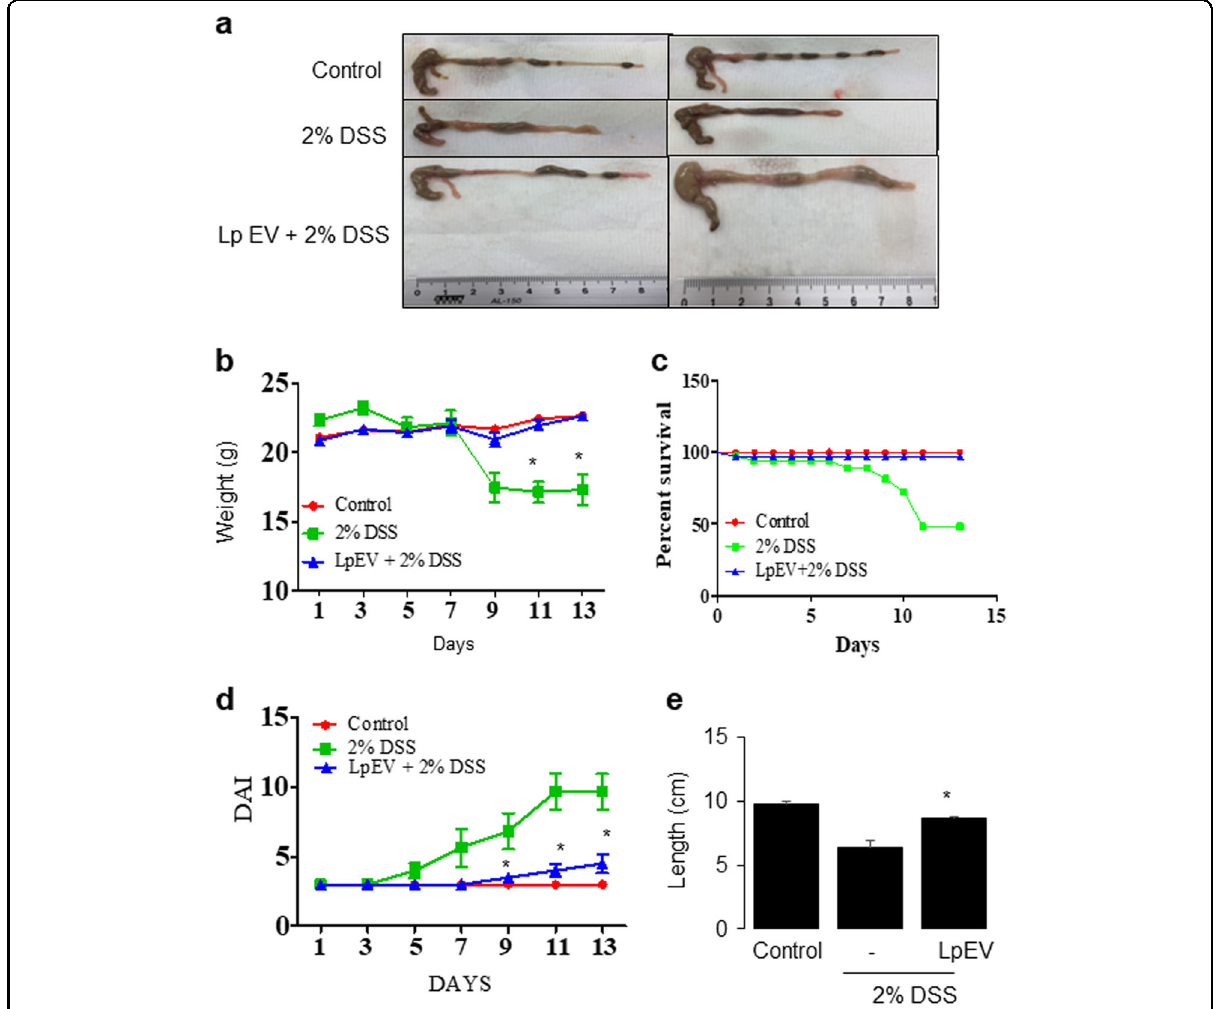
Fig. 4 Anti-in fl ammatory effect of LpEVs in a DSS-induced colitis mouse model. Seven-week-old male C57BL/6 mice were randomly assigned to three groups: the control, 2% DSS-only, and LpEV + 2% DSS groups. The mice were orally administered LpEVs (10 mg) in drinking water or 2% DSS for 5 days. a Images of colons from each group. b Body weight changes in all groups were measured every other day for 2 weeks. c Survival ratio. d Disease activity index. e Colon length. The results are expressed as the mean ± standard deviation of six mice. * P < 0.05 compared with 2% DSS-administered mice without